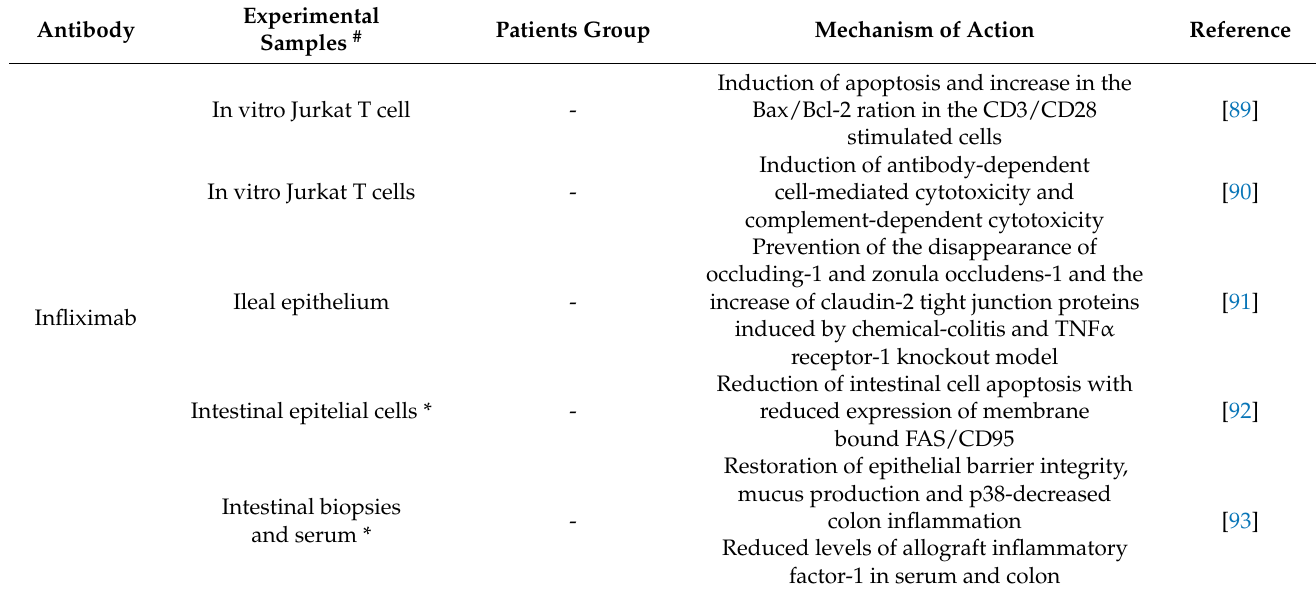
Table 3. Summary of studies evaluating the mechanistic effects of anti-TNF- α antibodies in inflammatory bowel disease.